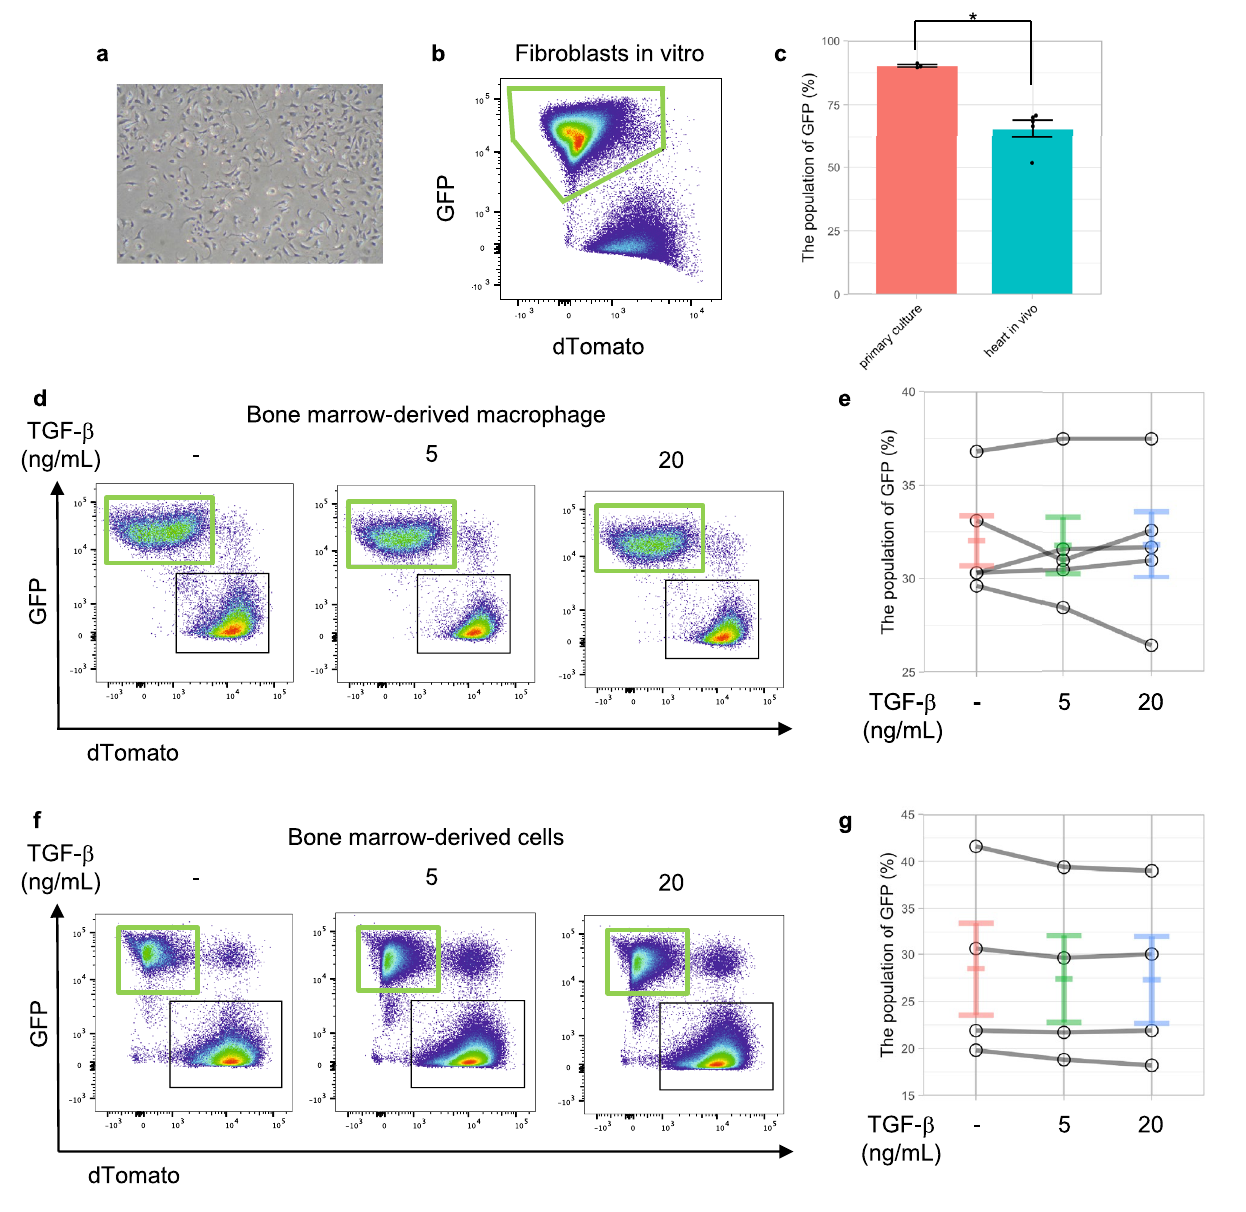
*p value < 0.01, evaluated by Student’s t test. ( d ) GFP expression in BMDMs with TGF-β stimulation. ( e ) No additional SM22α-Cre recombination in BMDMs with TGF-β stimulation, which increases SM22α expression. ( f ) GFP expression in bone marrow-derived cells with TGF-β stimulation. ( g ) No additional SM22α-Cre recombination in bone marrow-derived cells during differentiation from phenotypically defined putative HSCs to macrophages with TGF-β